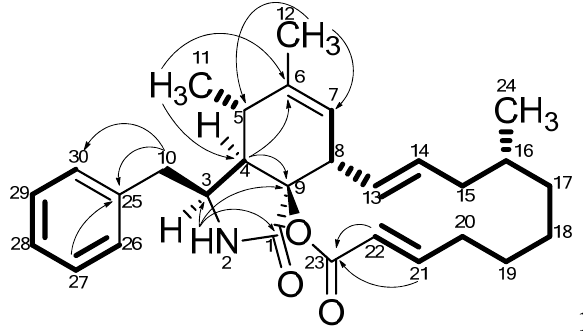
Figure 2. Important HMBC correlations connecting the four COSY spin systems (marked in bold) in 1 . The remaining HMBC correlations are found in Table